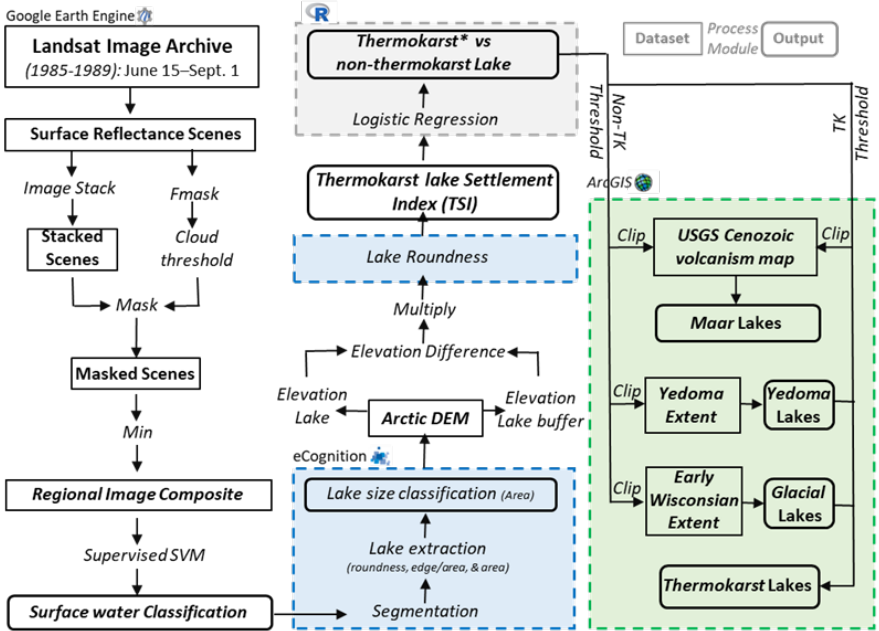
Figure 2. Schematic representation of the data processing workflow used to derive the Thermokarst lake Settlement Index (TSI) and map the distribution of lake origin across our study domain. Processing within Google Earth Engine (GEE), eCognition, R, and ArcGIS are indicated by background colors white, blue, grey, and green, respectively.